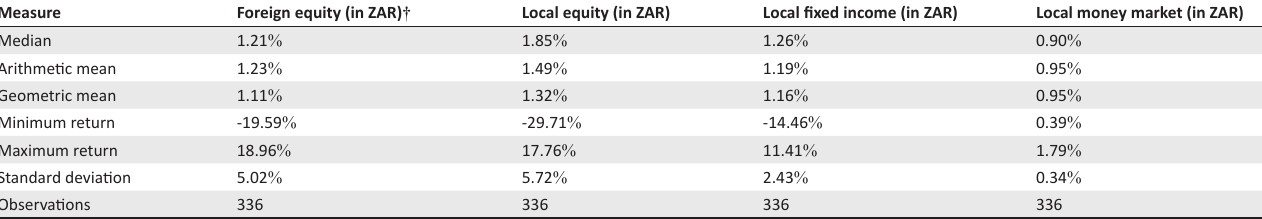
TABLE 2: Descriptive statistics of nominal total monthly returns of local and foreign asset classes (1986–2013). Measure